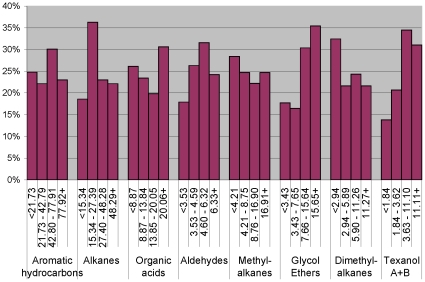
Prevalence of IgE-positive among the cases.